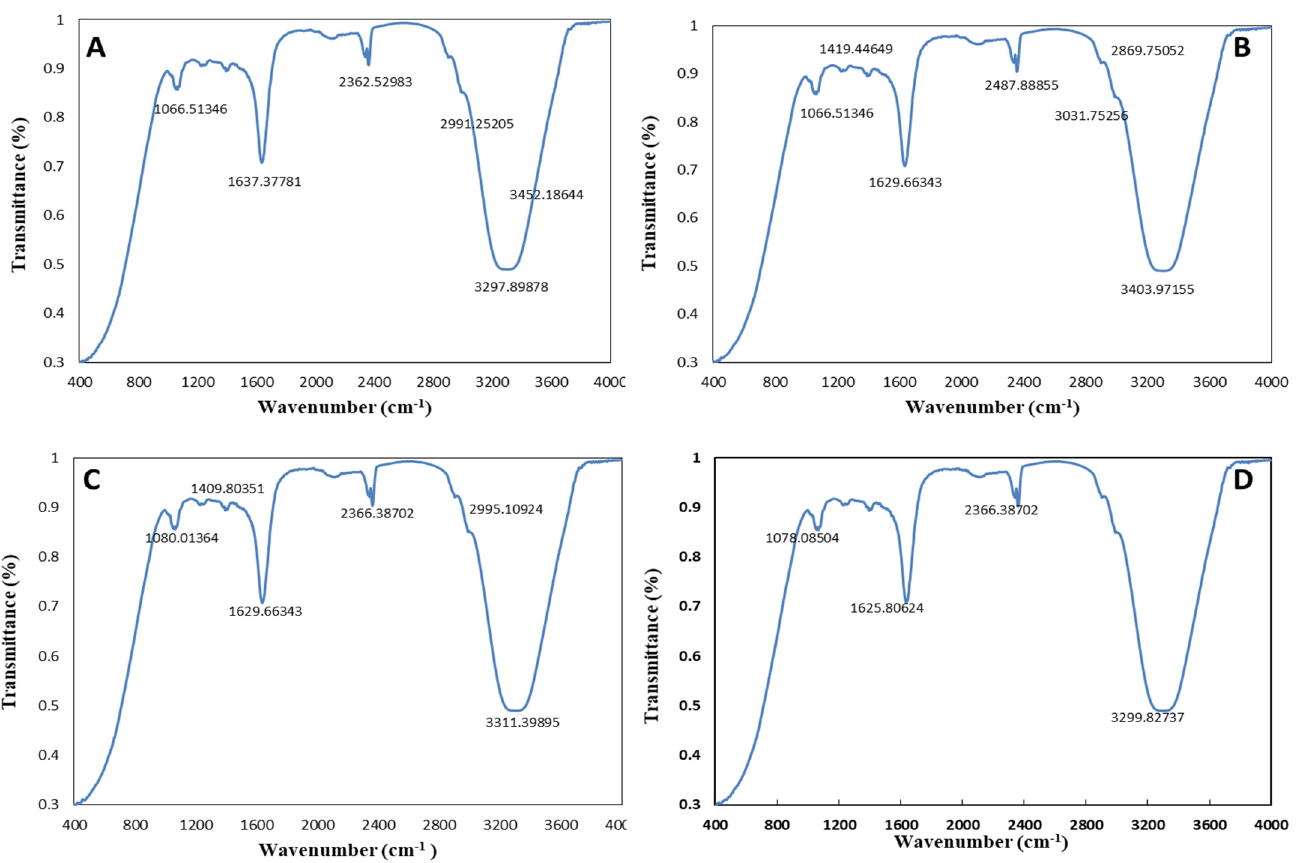
Figure 5. FTIR spectra of monometallic NPs. ( A ) Control AgNPs. ( B ) UV-C mediated AgNPs. ( C ) Control ZnONPs. ( D ) UV-C mediated ZnONPs.